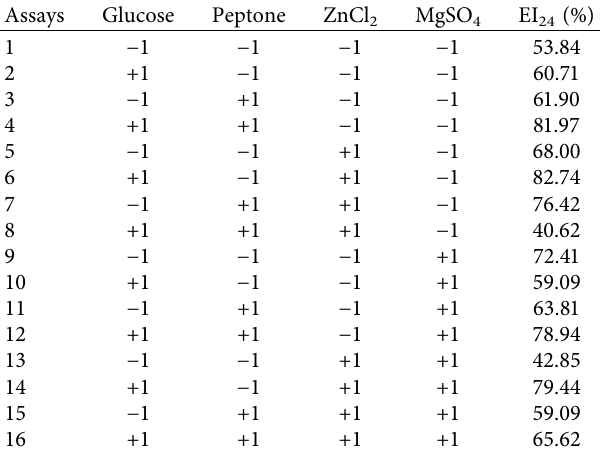
Table 2: Full-factorial design used for the production of bio- emulsifier by S. maltophilia UCP 1601 after 96 h of culture in medium containing 10% WSO. The tests were performed in triplicate and the media of emulsification index (EI) values were used as response variable.